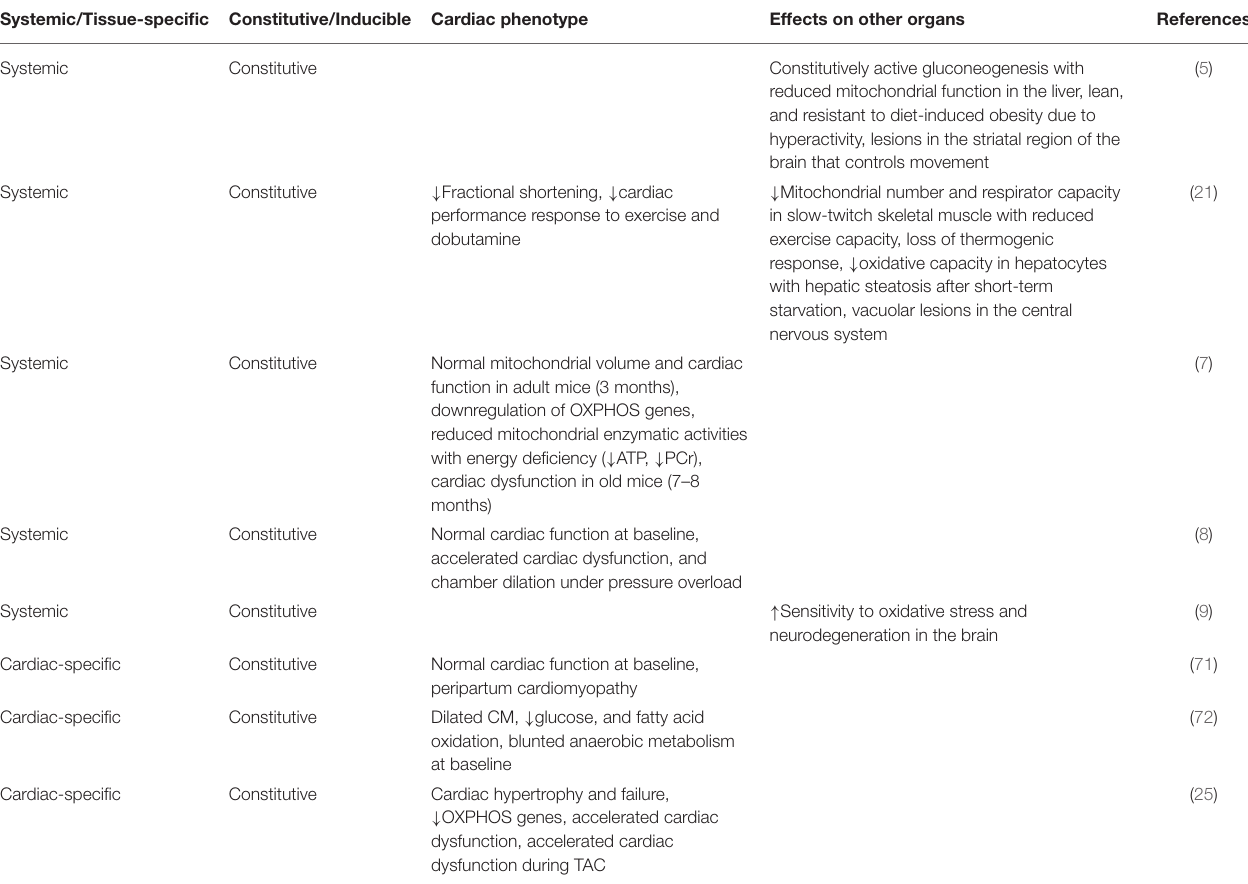
TABLE 2 | Phenotypes of the heart and other organs in PGC-1 α knockout mouse models. Systemic/Tissue-specific Constitutive/Inducible Cardiac